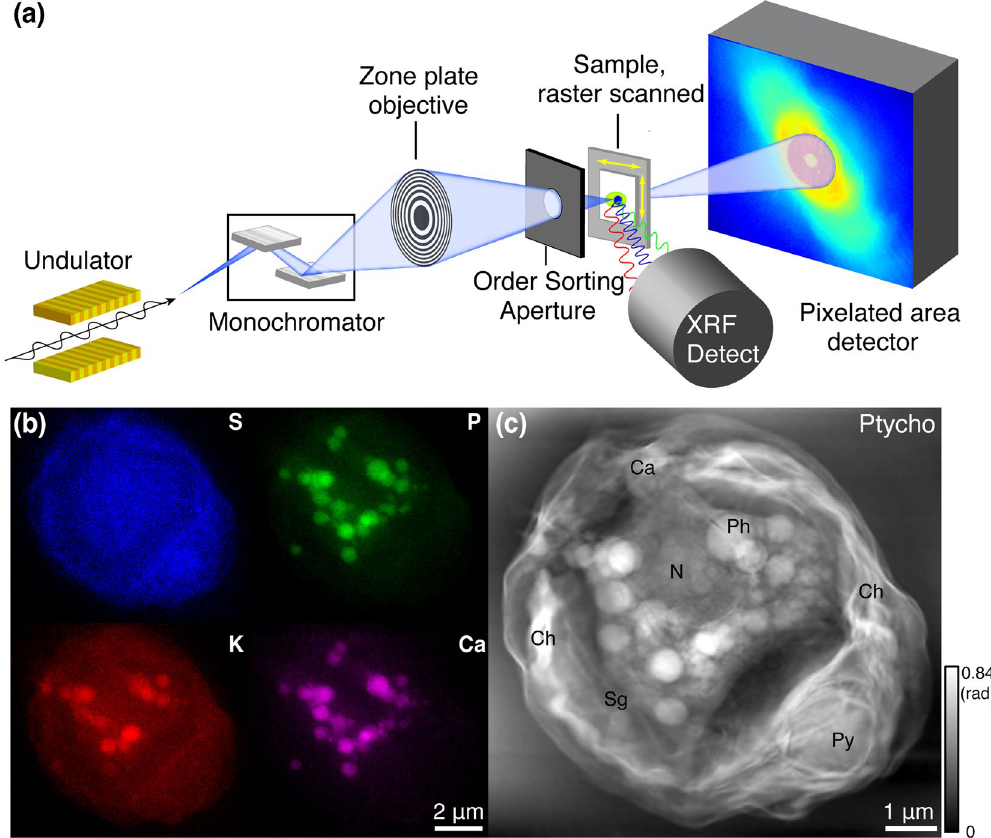
Figure 1. Combined x-ray fluorescence and ptychographic imaging of a frozen hydrated Chlamydomonoas reinhardtii alga. The x-ray microscope 27 is shown schematically in ( a ) 45 , where an energy-dispersive detector was used to record x-ray fluorescence and a pixelated area detector was used to record coherent diffraction patterns for ptychographic image reconstruction. The x-ray fluorescence maps of the elements S, P, K, and Ca shown in ( b ) have a spatial resolution that is consistent with the ~85 nm theoretical Rayleigh resolution of the focused x-ray beam, while the phase contrast ptychographic image ( c ) shows considerably more detail due to the reconstruction of x-ray scattering at an angle well beyond the numerical aperture of the Fresnel zone plate used. This image shows a single cup-shaped chloroplast (Ch), as well as a number of other organelles: pyrenoid (Py), nucleus (N), starch granule (Sg), and polyphosphate bodies (Ph). We also note the presence of granules (labeled Ca) with high calcium and phosphorus content, but low sulfur and potassium